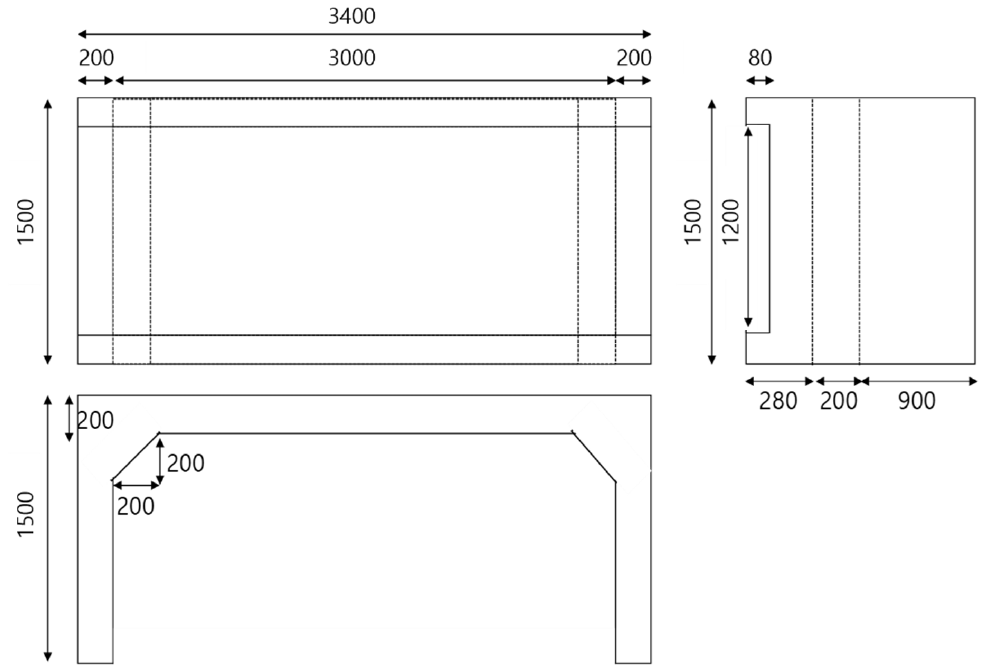
Figure 2. Dimensions of rigid-frame-bridge modeling (units: mm).